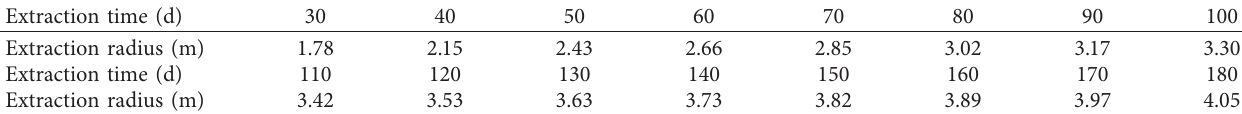
Table 5: Average extraction radius at different extraction times.